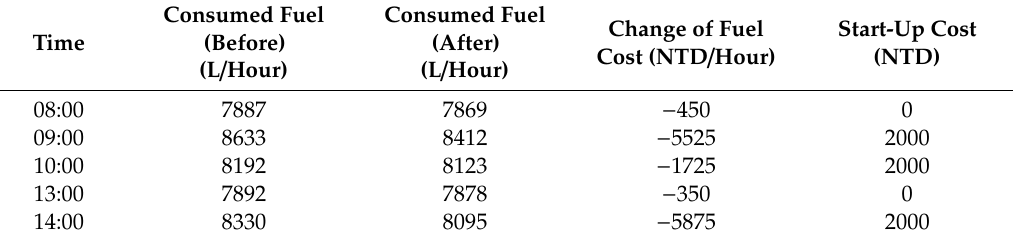
Table 6. The cost analysis of the GR methods.